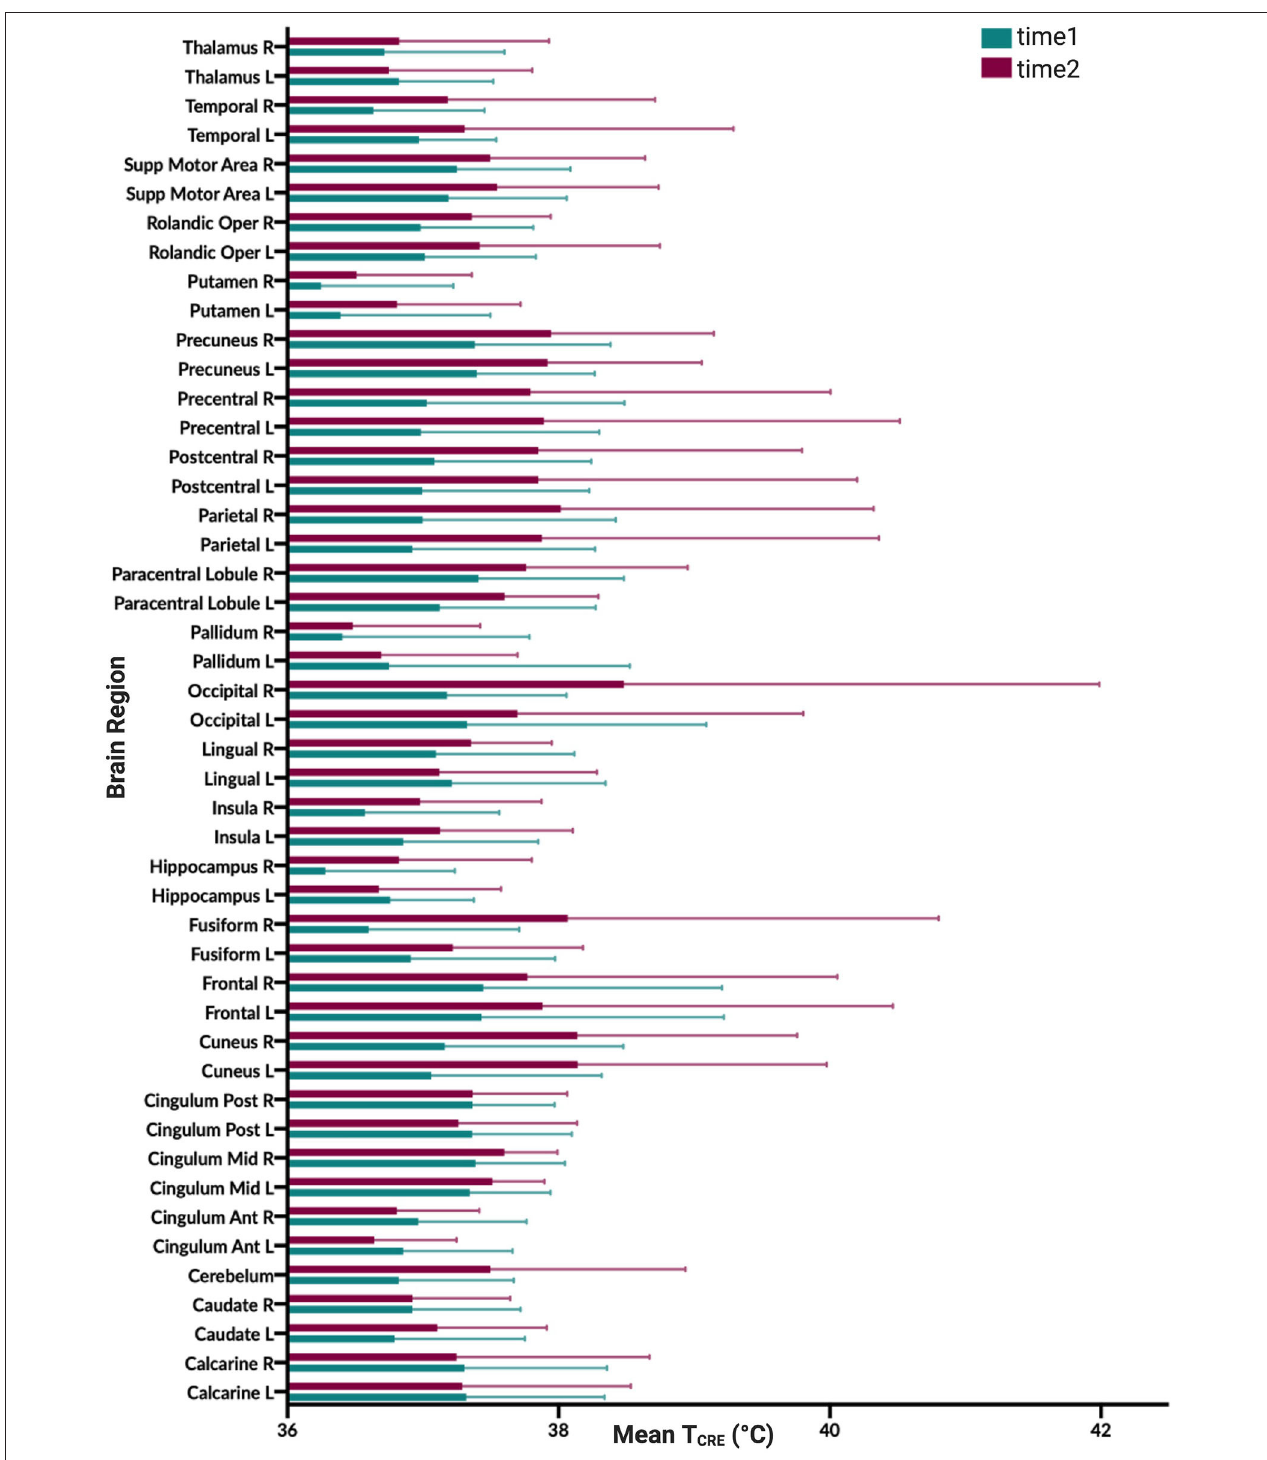
FIGURE 3 | Graphical illustration of mean brain temperature for time1 (mean 37.0 ◦ C) and time2 (37.4 ◦ C) across 47 regions of interest (ROIs) delineated by the modified Automated Anatomical Labeling (AAL) atlas. Brain temperature was non-invasively derived from volumetric magnetic resonance spectroscopic imaging (MRSI) data, using the following equation: T CRE = − 102.61( 1 H20 − CRE ) + 206.1 ◦ C, where 1 H20 − CRE = chemical shift difference between the creatine and water resonances. For each brain region, colored bars (time1, teal; time2, burgundy), reflect the mean T CRE ; whiskers indicate range of T CRE values beyond the mean. The mean global brain temperature over all subjects was 37.2 ◦ C with spatial variations across regions (37.57–41.49 ◦ C). There was a significant main effect for time [ F (1, 1,591) = 37.0, p < 0.0001] and for brain region [ F (46, 1,591) = 2.66, p < 0.0001]. The time*brain region interaction was not significant [ F (46,1,591) = 0.80, p = 0.83].